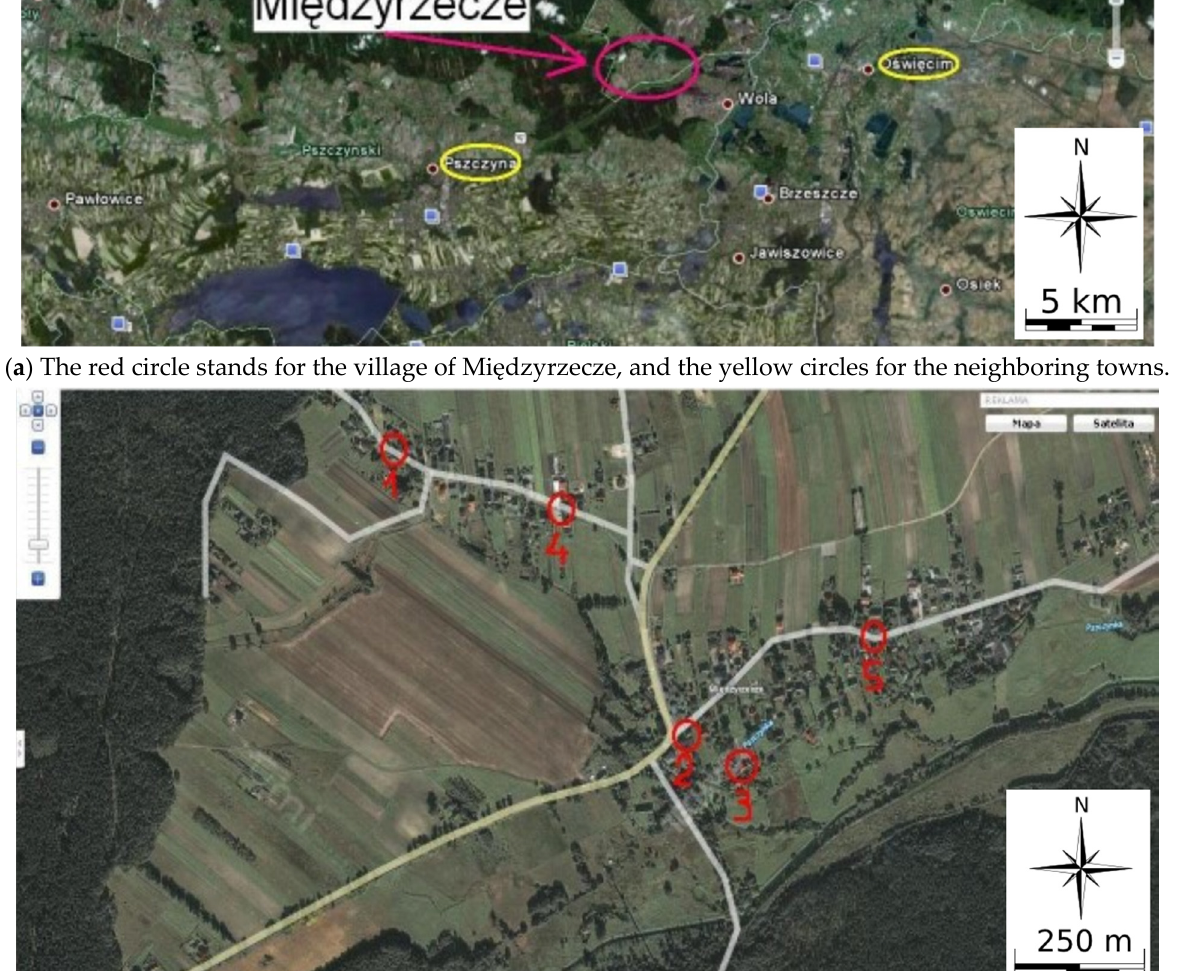
( b ) The red circles represent all the houses under study in the village of Mi ę dzyrzecze. A red number indicates a couple of houses, one with no smokers and one with the ETS. Figure 1. Location of Mi ę dzyrzecze ( a ) and the studied houses ( b ). Sources: Google. Figure 1. Location of Mi˛edzyrzecze ( a ) and the studied houses ( b ). Sources: